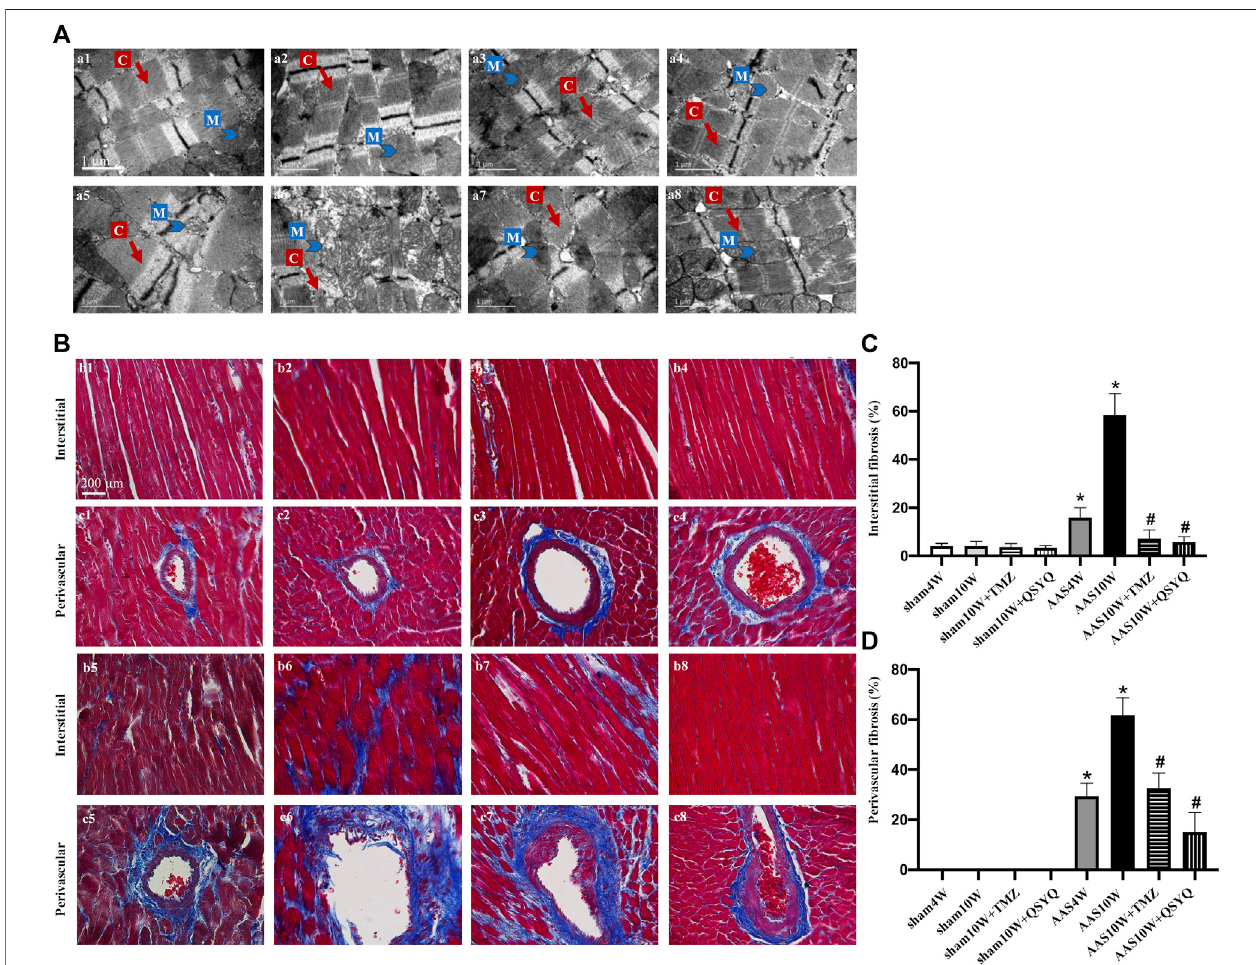
FIGURE 1 | QSYQ post-treatment inhibited myocardial fi ber rupture and cardiac fi brosis. (A) Effects of QSYQ post-treatment on the ultrastructure of myocardial tissues of rats in the Sham4W (a1), Sham10W (a2), Sham10W + TMZ (a3), Sham10W + QSYQ (a4), AAS4W (a5), AAS10W (a6), AAS10W + TMZ (a7), and AAS10W + TMZ (a8) groups. Scale bar = 1 μ m. (B) Representative images of Masson ’ s trichrome staining in the Sham4W (b1 and c1), Sham10W (b2 and c2), Sham10W + TMZ (b3 and c3), Sham10W + QSYQ (b4 and c4), AAS4W (b5 and c5), AAS10W (b6 and c6), AAS10W + TMZ (b7 and c7), and AAS10W + TMZ (b8 and c8) groups. Scale bar = 200 μ m. (C,D) Quanti fi cation results of interstitial fi brosis and perivascular fi brosis measured by Masson ’ s trichrome staining. Data are presented as the mean ± SEM, n = 3. * p < 0.05 vs. sham; # p < 0.05 vs. AAS. AAS, ascending aortic stenosis; C: cardiac myo fi bril; M: